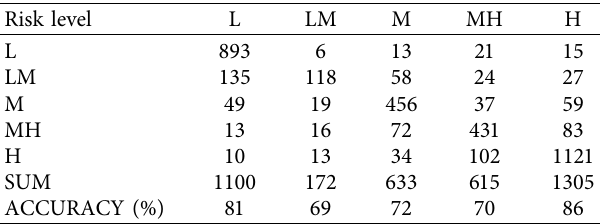
Table 5: Confusion matrix under a prediction horizon of